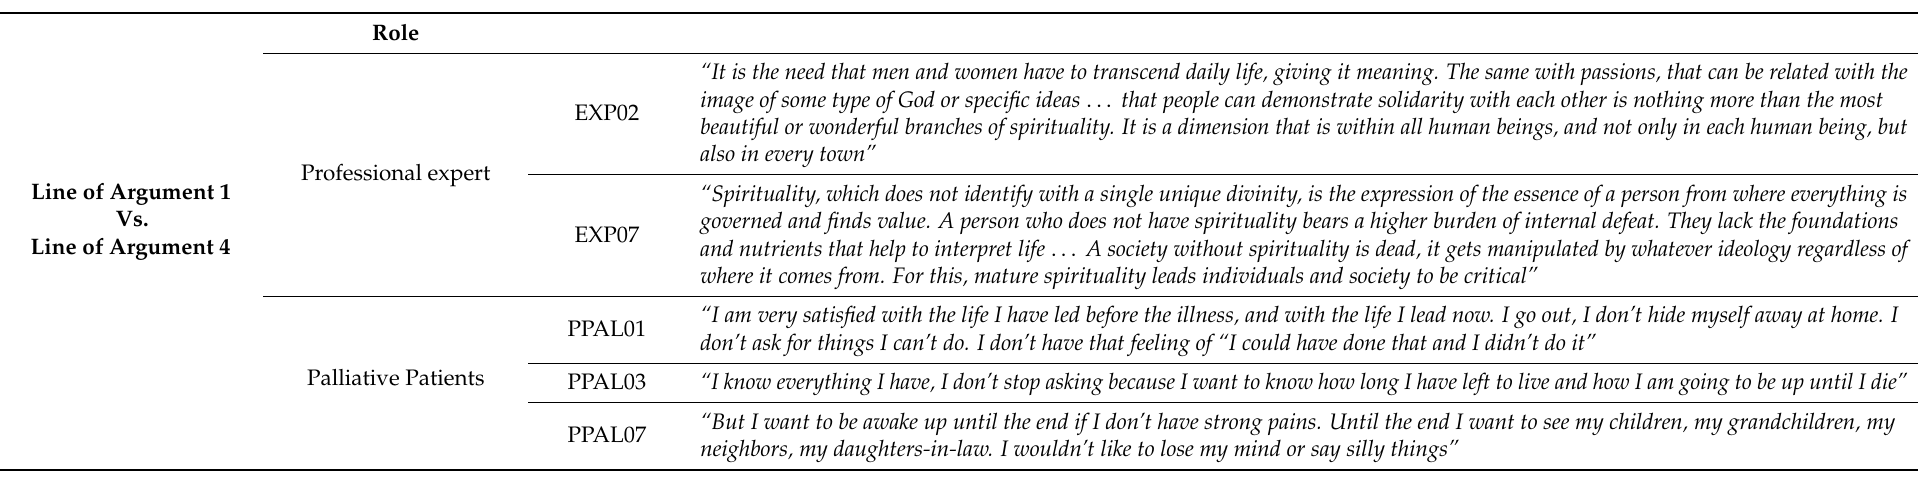
Table 4. Line of argument 1 patients: Concept of spirituality vs. line argument 4 Professional expert: Concept of